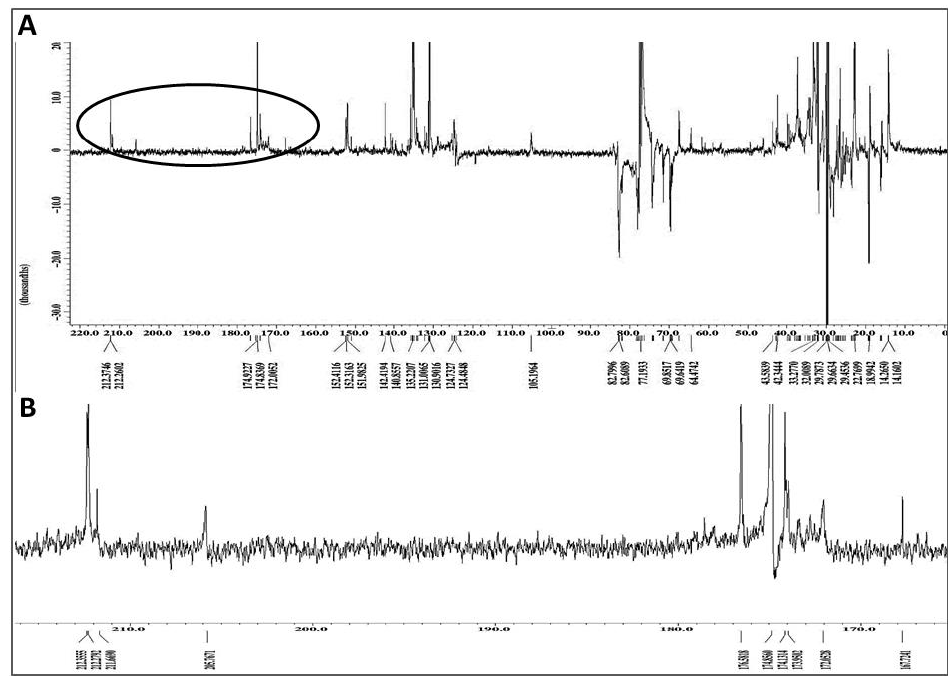
Figure 7. Chemical fingerprint of the dichloromethane (DCM) subfraction of GLSE. ( A ) Full PENDANT- 13 C NMR spectrum of the graviola DCM extract in CDCl 3 showing methylene and quaternary carbons up and methine and methyl carbons down. The full spectrum shows four different signal clusters as explained in the text; and ( B ) Expansion of the circled portion of the spectrum from panel A containing lactone/ester carbonyl and ketone carbons clusters circled in PENDANT spectrum.